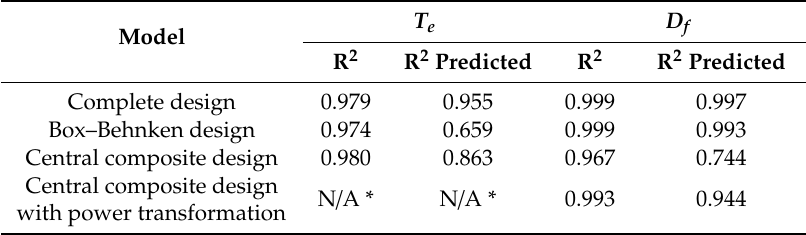
Table 4. Regression coe ffi cients of the di ff erent RSM optimisation